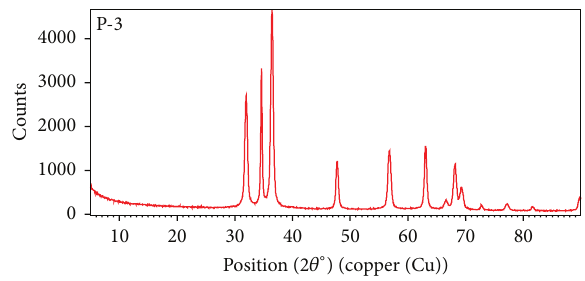
Figure 2: XRD pattern of ZnO